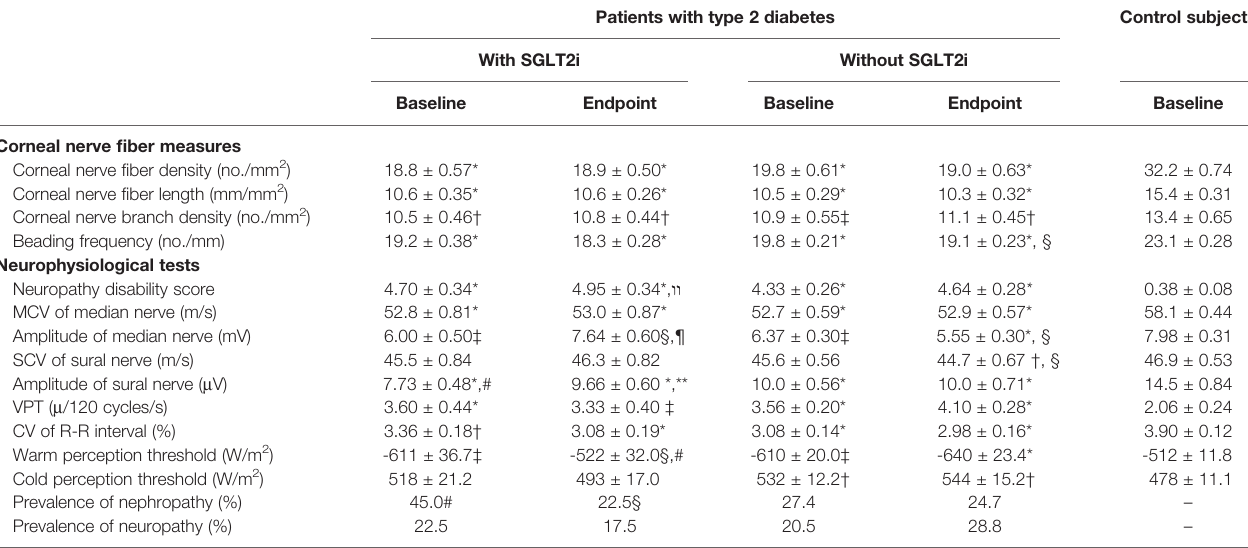
TABLE 2 | Corneal nerve fi ber measures, neurophysiological tests and microvascular complications at the baseline and endpoint in patients with type 2 diabetes treated with or without sodium glucose cotransporter-2 inhibitor and at the baseline in control subjects. Patients with type 2